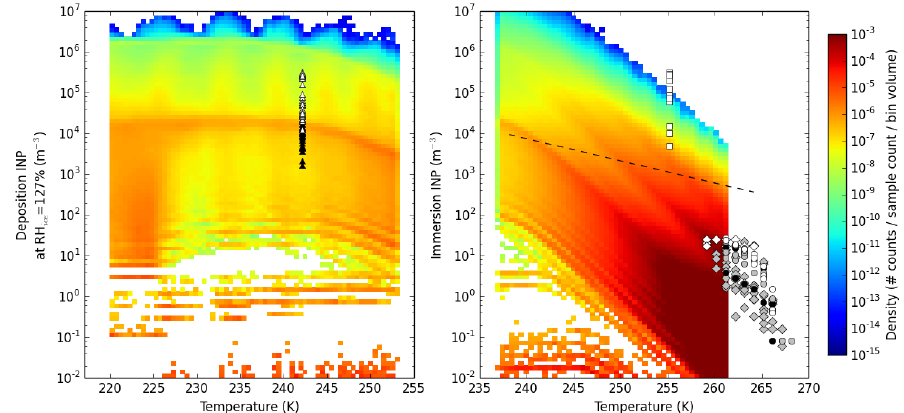
Figure 4. Left: normalised potential deposition INPs at RH ice = 127%. Right: normalised potential immersion INPs for July 2008, compared to observations. Observations are shown from Chou et al. (2011) (white triangles: Saharan dust event, black triangles: non-dust event), Conen et al. (2012) (black circles: dust from North Italy, grey circles: dust from North Africa/Switzerland, white circles: dust from Switzerland/South Germany), DeMott et al. (2010) (dashed line), Joly et al. (2014) (grey diamonds: within detection limit, white diamonds: at detection limit) and Klein et al. (2010) (white